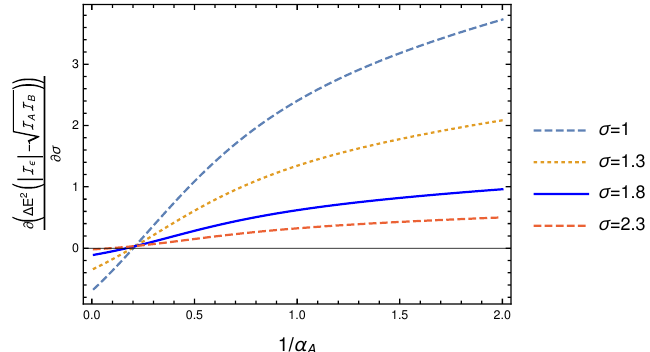
Figure 4 . In (1+1) dimensions the derivative with respect to σ of the quantity ∆ E 2 is plotted for two anti-parallelly accelerating detectors for varying σ . The other parameters α and α are fixed. A